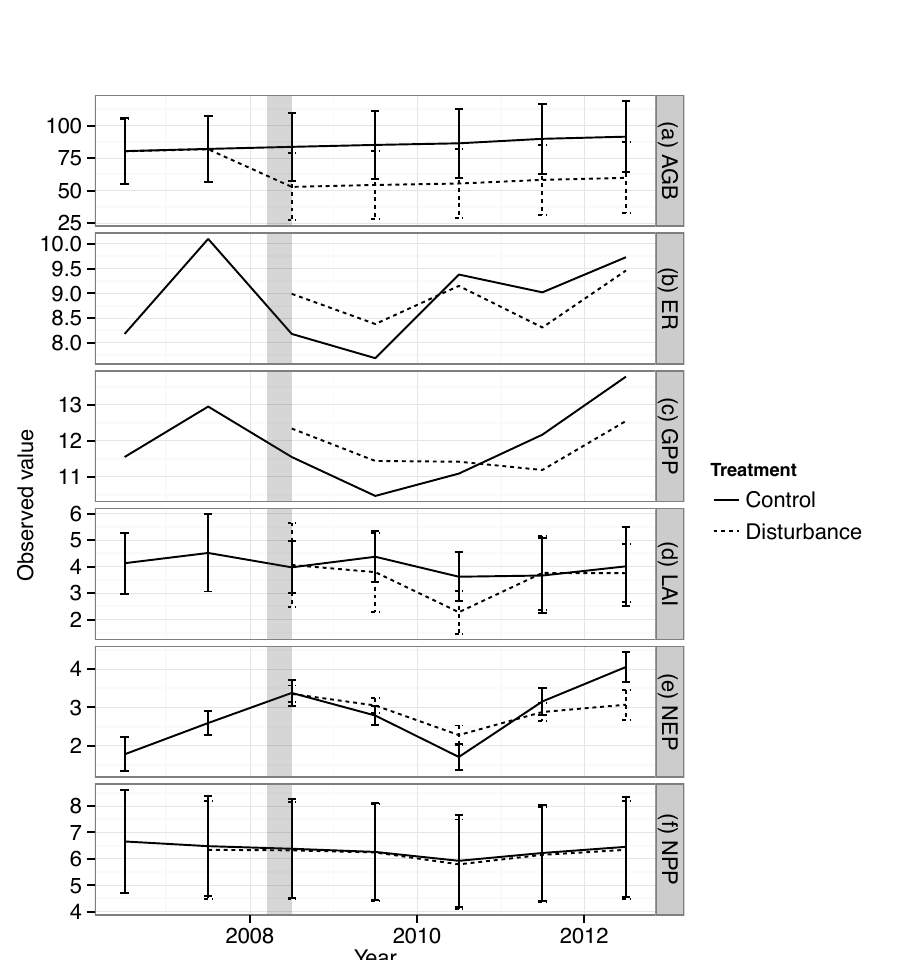
Figure 1. Observed data from FASET treatment and control forests. Panels include (a) aboveground biomass (AGB, in MgCha − 1 ) , (b) ecosystem respiration (ER, MgCha − 1 ) , (c) GPP (MgCha − 1 ) , (d) leaf area index (LAI, unitless), (e) net ecosystem production (NEP, MgCha − 1 ) , and (f) net primary production (NPP, MgCha − 1 ) . Vertical shaded area shows approximate time of the girdling treatment described in the text. Error bars indicate ± 1SD based on eight measurement plots (Gough et al., 2013). Control and treatment sites had near-identical data in 2006 and 2007, and thus the latter (dashed) line is not visible in panels (a) , (d) , and (f) in those